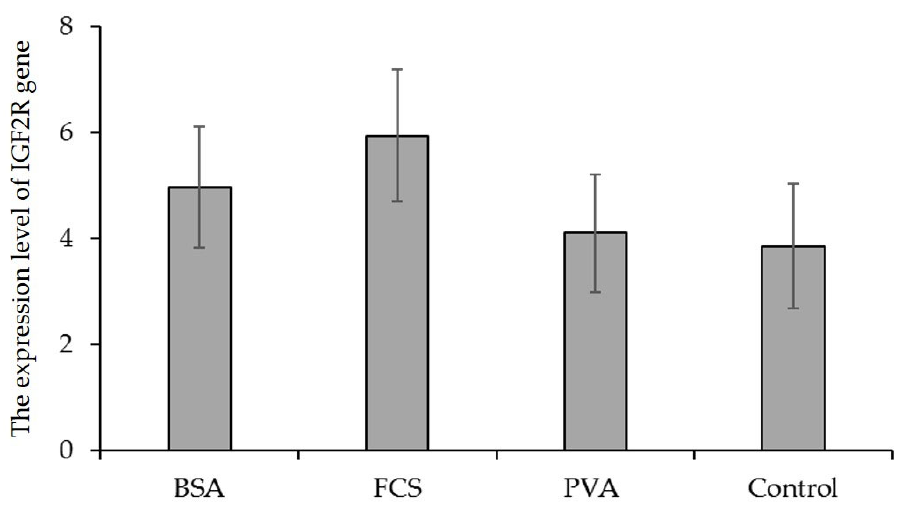
Figure 5. The expression level of the IGF2R gene in bovine oocytes matured in media supplemented with different macromolecules. BSA = bovine serum albumin, FCS = fetal calf serum, PVA = polyvinyl alcohol. The error bars represent the standard error of means.